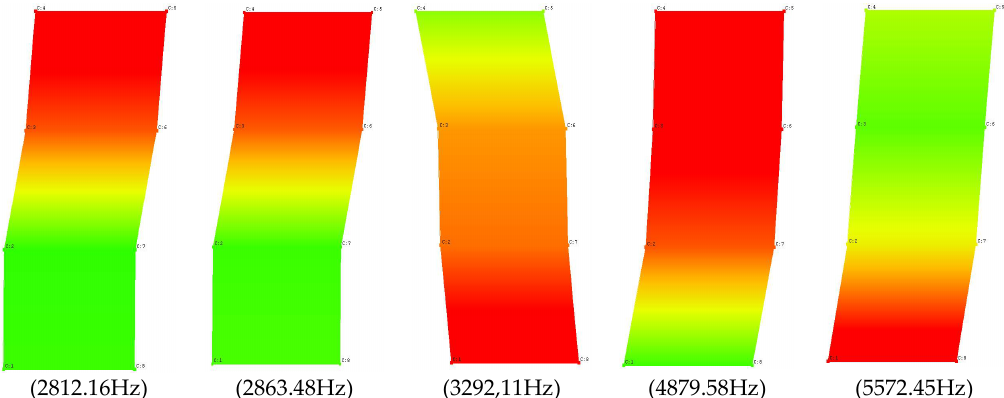
Figure 11. Natural frequency values of the undamaged solid ceramic brick. Figure 10. Natural frequency values of the undamaged solid ceramic brick.